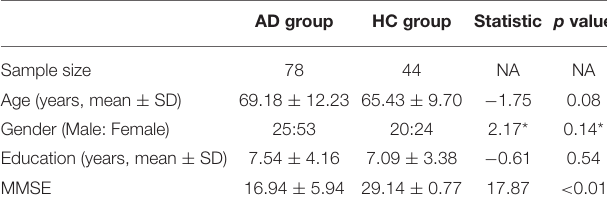
TABLE 2 | Demographics performances of the AD and healthy controls.